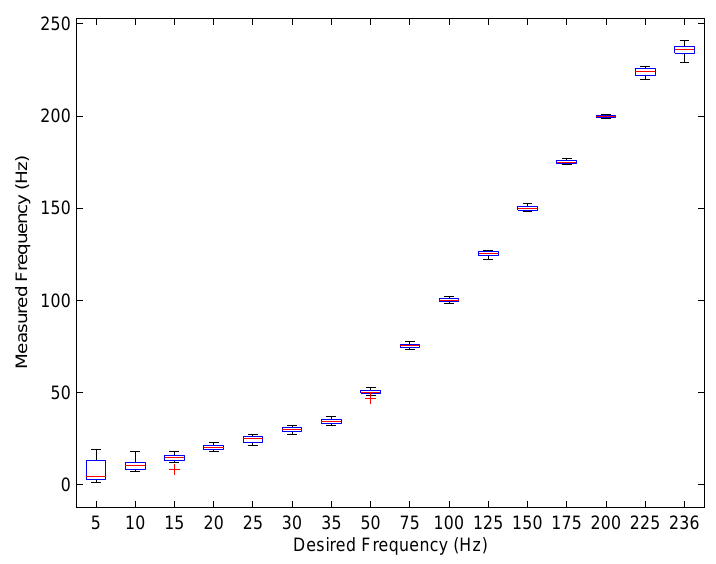
Figure 9. Box plot of measured frequency versus excitation frequency of the fabricated sensor. The minimum standard deviation in sensor output, in terms of frequency is 0.649 Hz at 200 Hz.